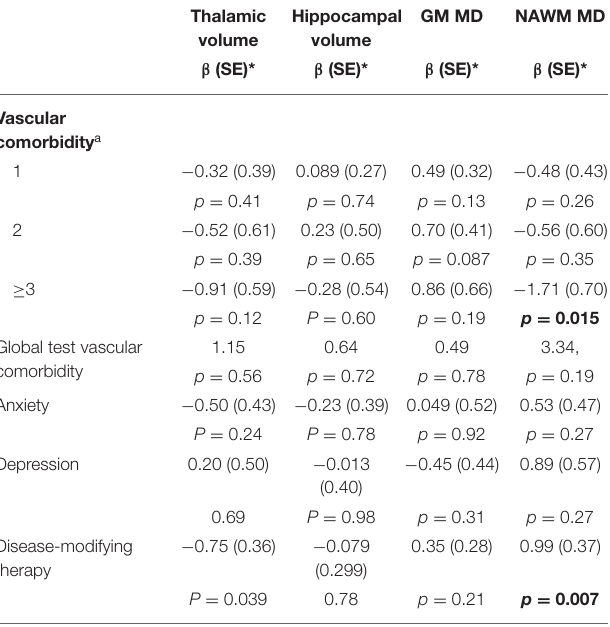
TABLE 4 | Association of vascular comorbidity with individual magnetic resonance imaging